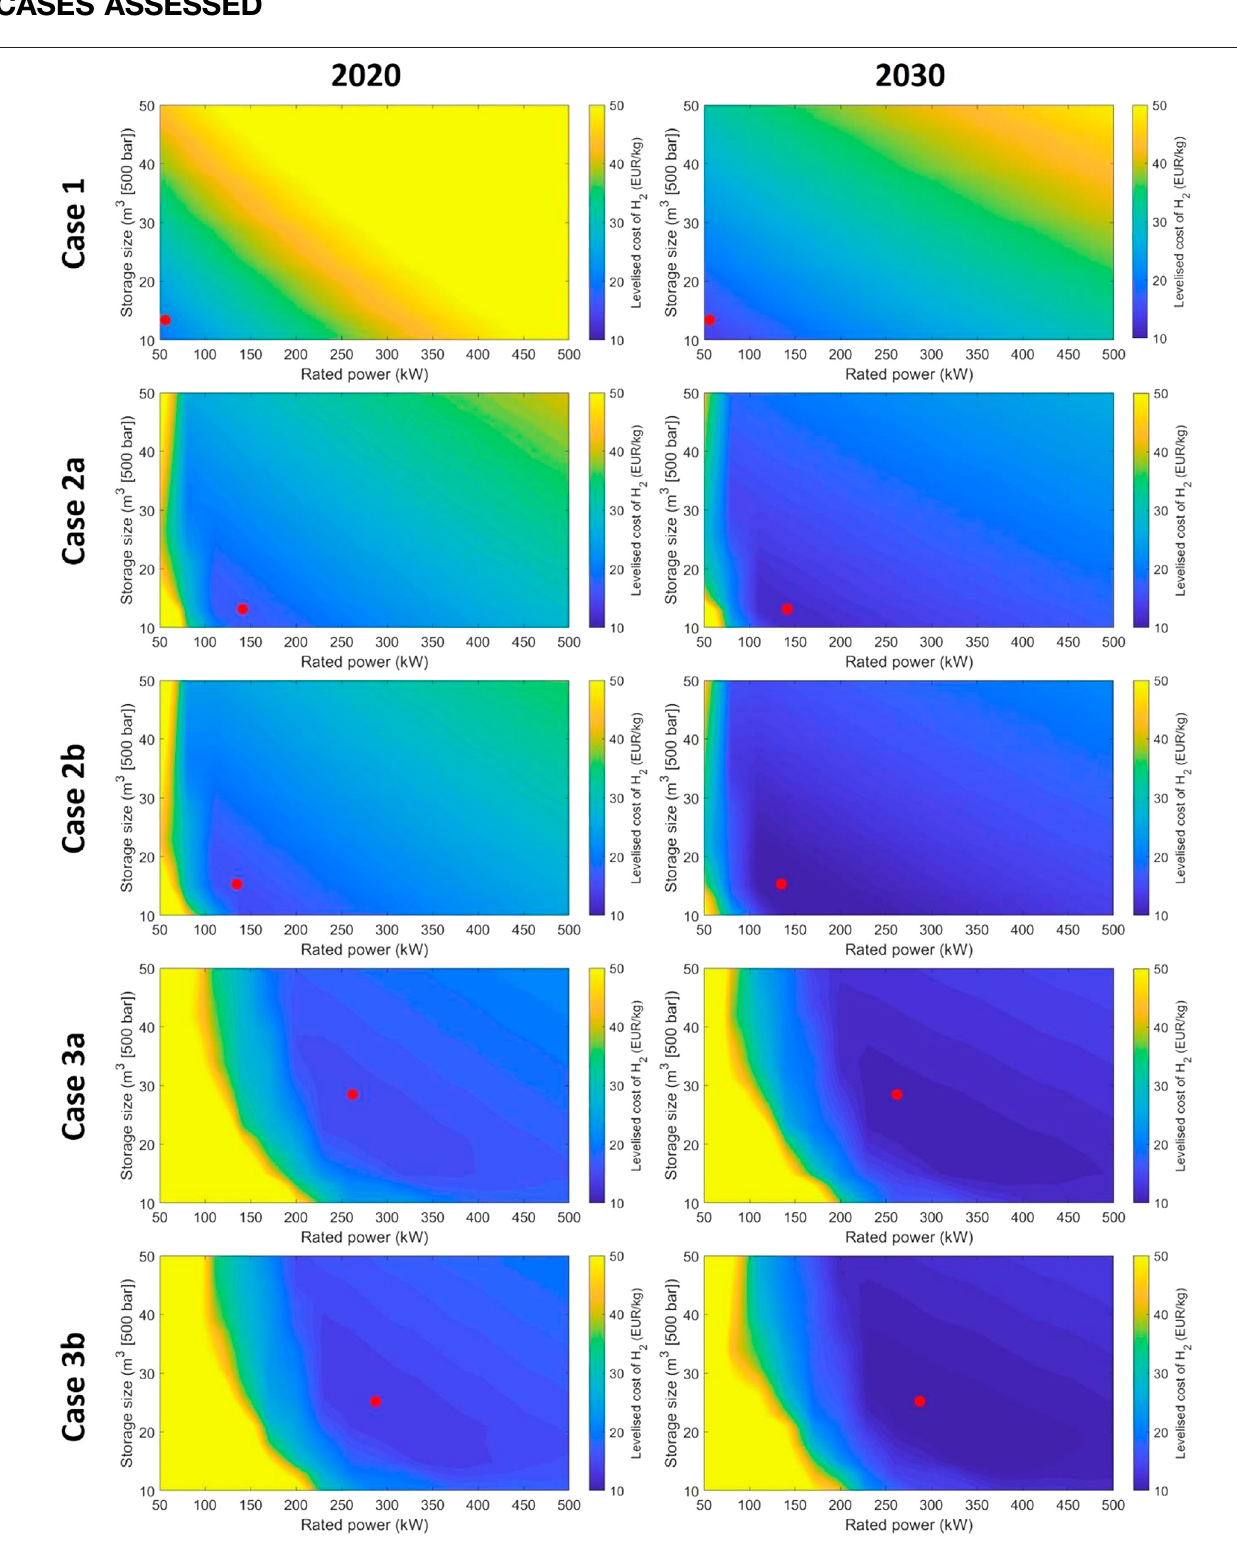
Frontiers in Energy Research |